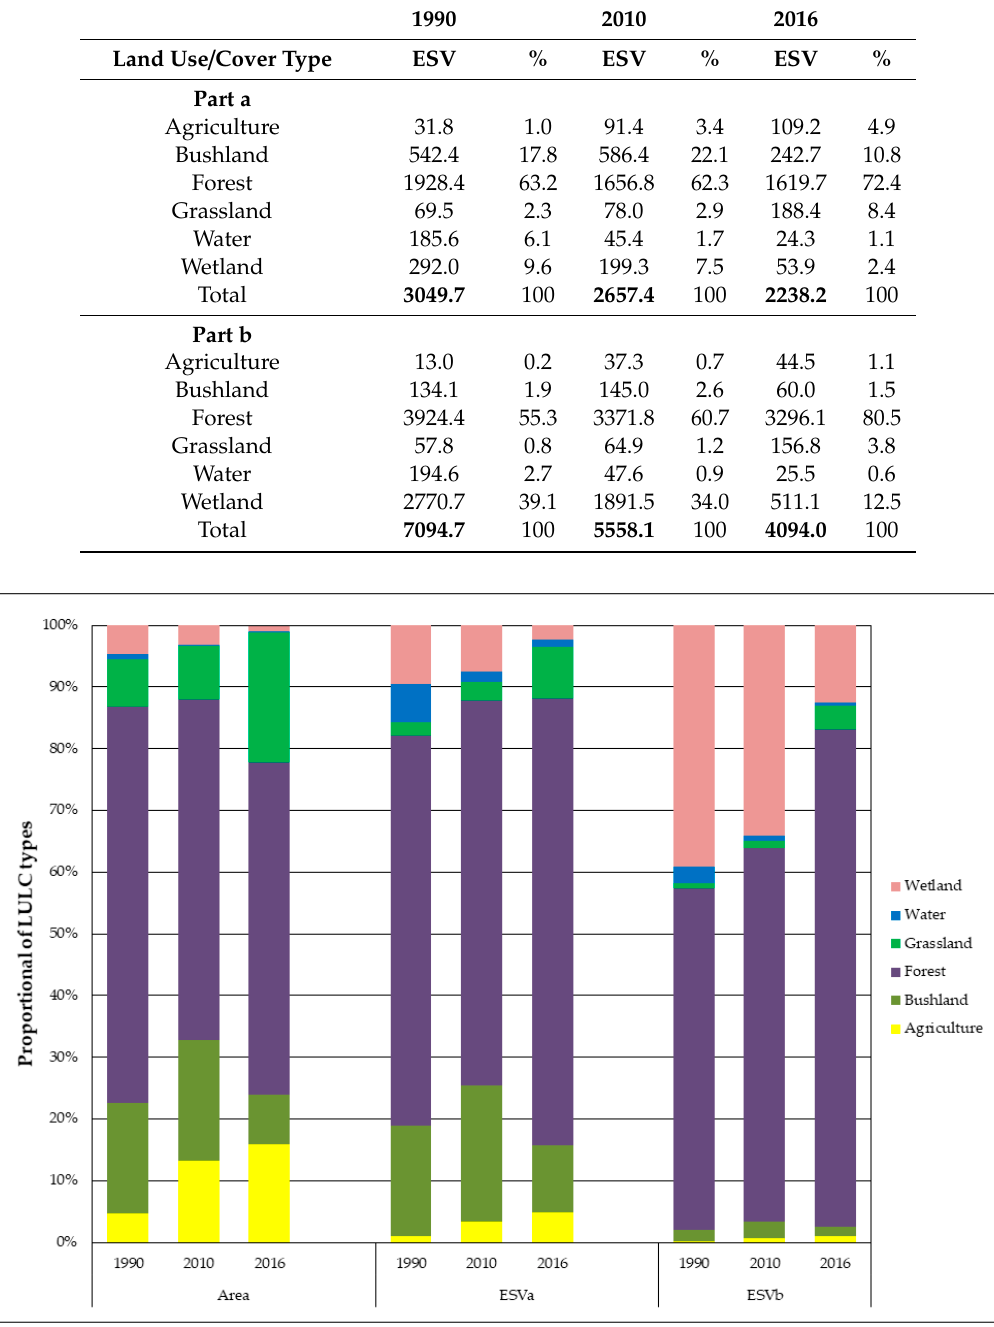
Figure 3. Contributions of the areas and ecosystem service values in percentages by LULC types in 1990, 2010, and 2016 in the Kilombero Valley floodplain (ESV a = value obtained using the modified local value coefficients adopted from Kindu et al. and Temesgen et al. [7,33], with permission from Elsevier, 2016 and MDPI, 2018, respectively and ESV b = the value obtained by using the global value coefficients of Costanza et al. [1], with permission from Nature research, 1997).